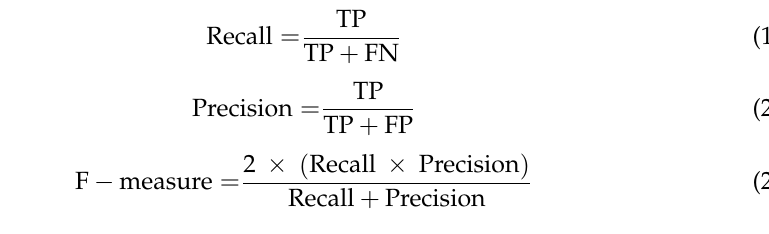
Table 8. The performance measures for both